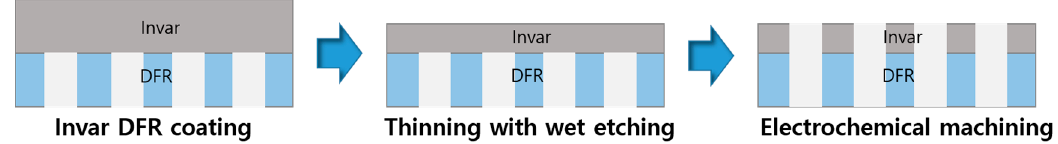
Figure 15. Wet etching and electrochemical fusion machining (photoresist coating opposite face etching).